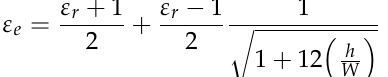
Figure 7. Photograph of ( a ) main fabricated biosensor with the stub resonators coated with MIP and NIP and ( b ) duplicate biosensor coated with MIP and uncoated under the microscope.